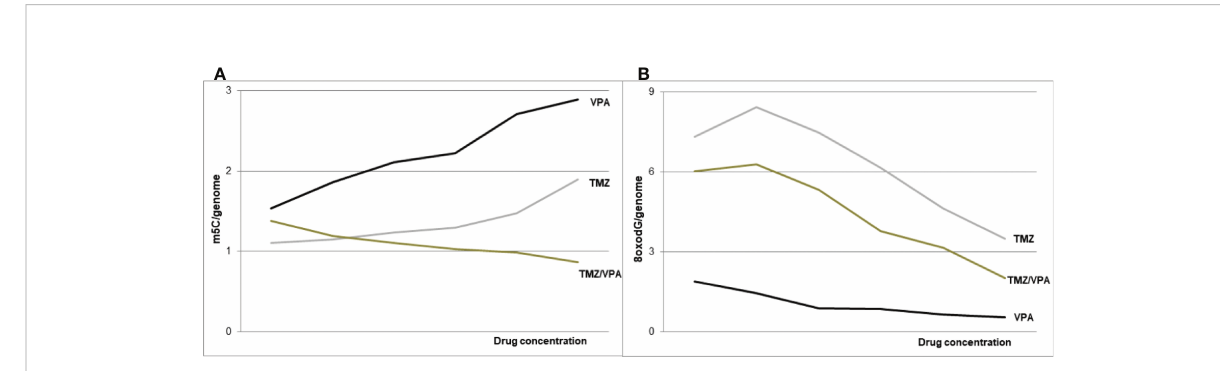
FIGURE 7 The schematic of VPA and TMZ impact on DNA (m 5 C) methylation – (A) and DNA (8-oxo-dG) oxidation – (B) , alone and in combination. The concomitant application of the both drugs induces DNA